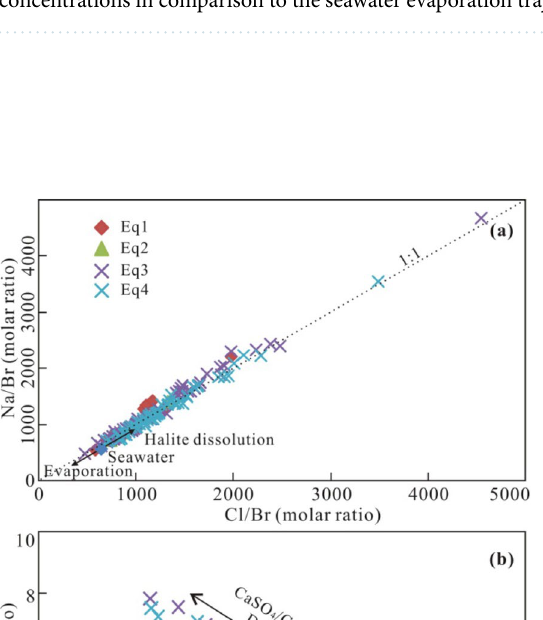
Figure 3. ( a ) Plot of Na/Cl molar ratios vs. Cl concentrations. ( b ) Plot of Cl/Br molar ratios vs. Cl concentrations in comparison to the seawater evaporation trajectory 31 .